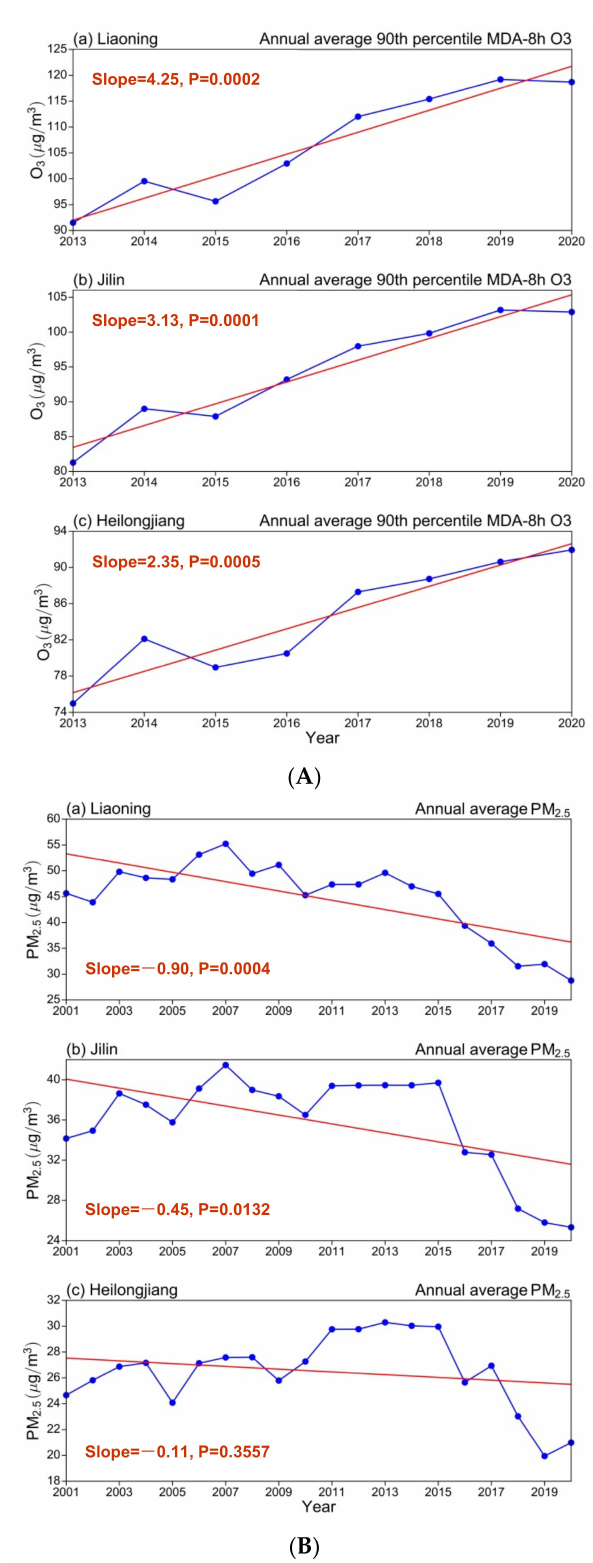
Figure 7. Interannual trend of mean annual concentrations of ( A ) O 3 -8h-90per from 2013–2020 and ( B ) PM 2.5 from 2001–2020 in ( a ) Liaoning, ( b ) Jilin and ( c ) Heilongjiang province over NEC. Red solid lines indicate slopes with a linear trend and statistical significance at the 95% confidence level ( p <